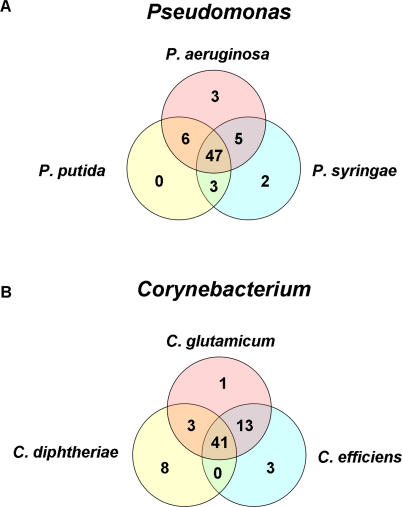
Venn Diagrams Showing the Distribution of Transporter Families among Species Belonging to the Same Genus(A) Transporter family distribution among three Pseudomonas species.(B) Transporter family distribution among three Corynebacterium species.